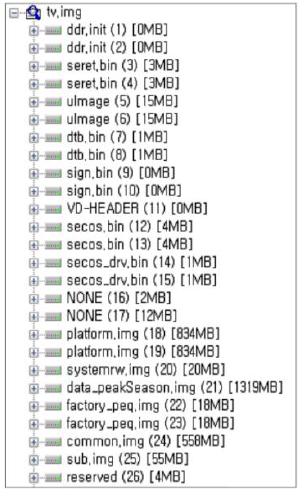
Figure 4. Smart TV partition.